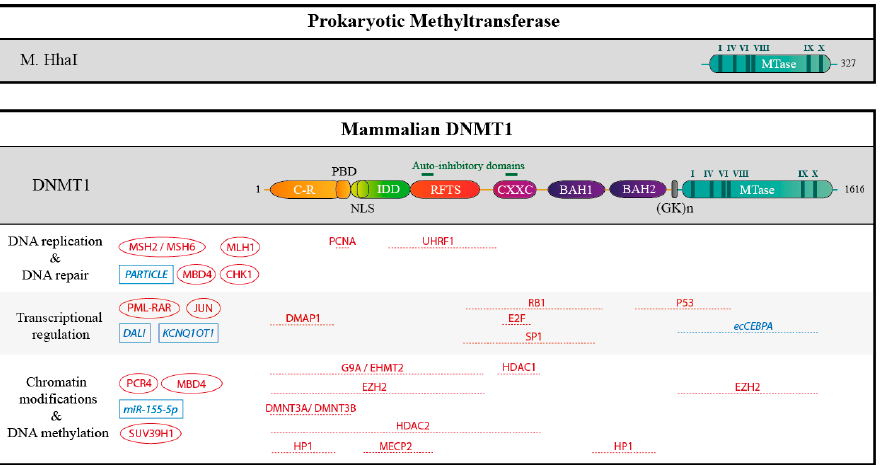
Figure 4. Schematic structure of the prokaryotic methyltransferase M. HhaI, compare to DNMT1 and partners. The human DNMT1 contains 1616 amino acids residues. The catalytic methyltransferase